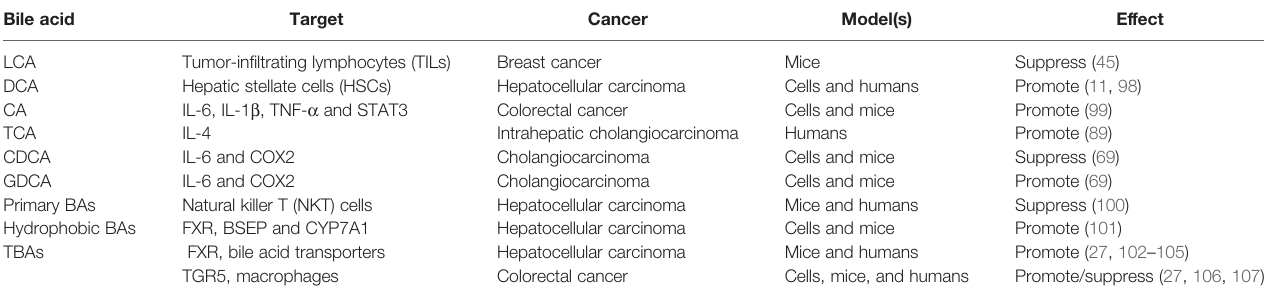
TABLE 4 | The impact of bile acid on cancer in fl ammation and immunity. Bile